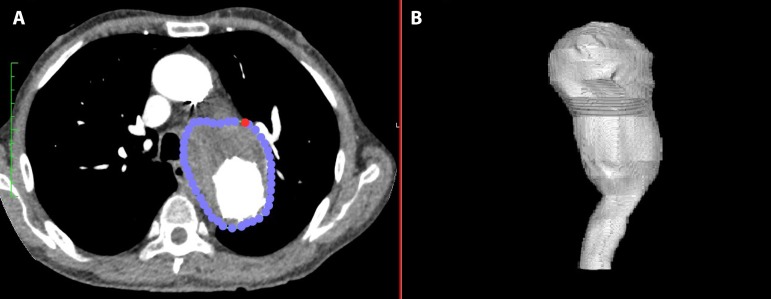
Steps of volume calculation: individually placed points delimitates
the outer margin of total aorta at each axial image (A); resulting
three-dimensional reconstruction (B).